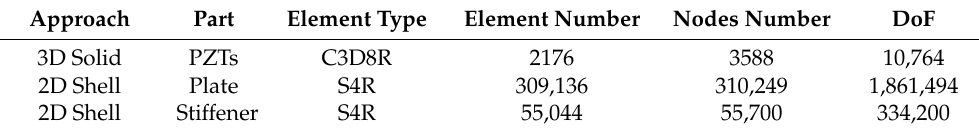
Table 3. FE modelling details for the stiffened panels. Figure 2. Stiffened panels geometry.